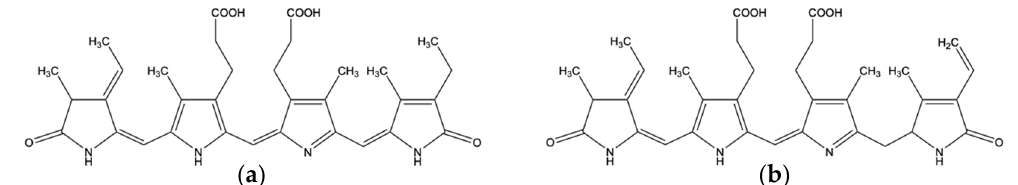
Figure 3. Chemical structure of the phycobilins present in phycocyanin and phycoerythrin, respectively: ( a ) Phycocyanobilin; ( b ) Phycoerythrobilin .